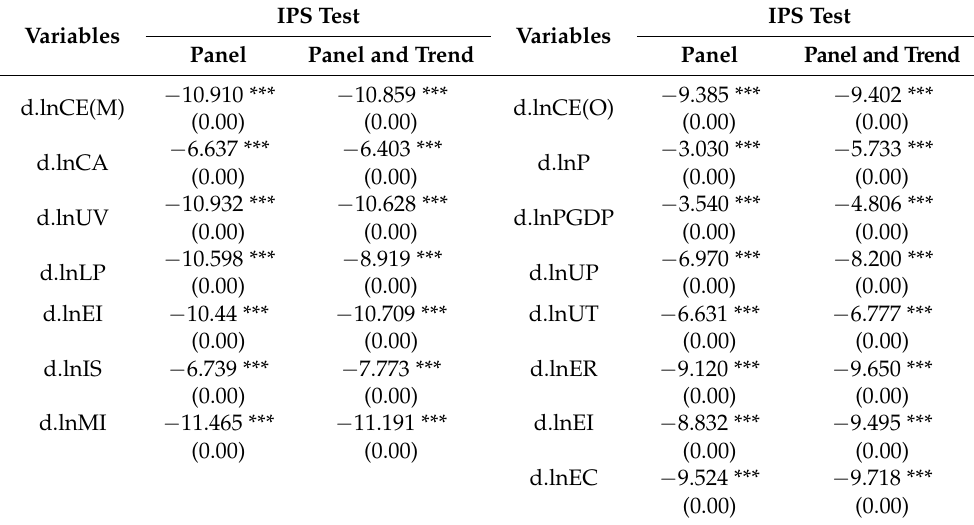
Table 4. IPS test results after 1st difference.